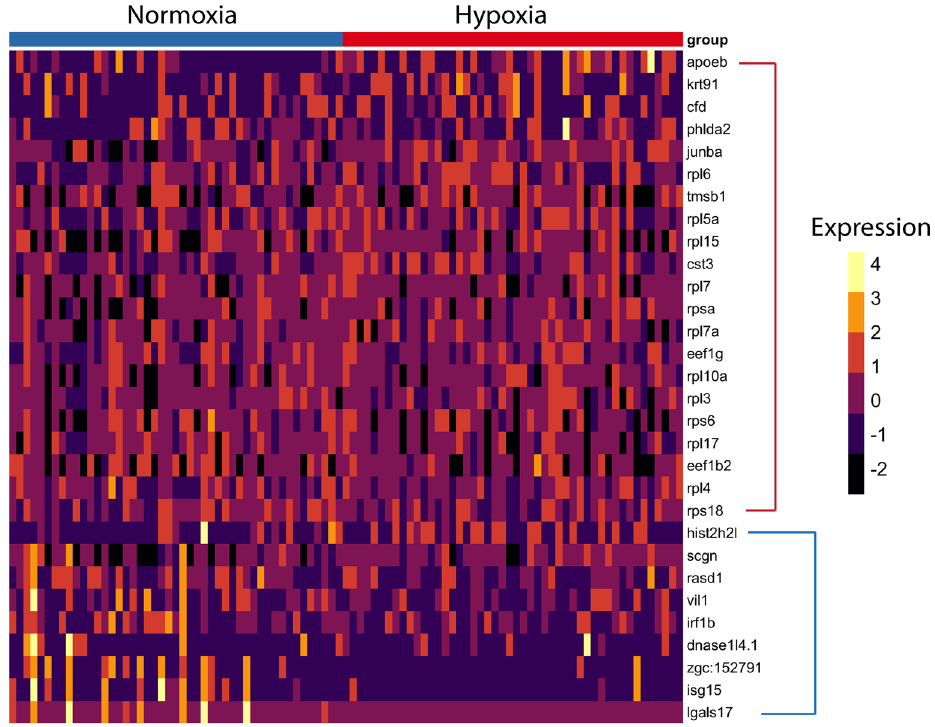
Figure 7. Differential gene expression analysis of NECs between normoxic and hypoxic conditions using the DEsingle method. Heatmap of highly enriched genes that were statistically significant (P < 0.05) in both normoxic and hypoxic conditions in the NEC cluster. Genes enclosed in the red bracket were significantly expressed in hypoxia. Genes enclosed in the blue bracket were significantly expressed in